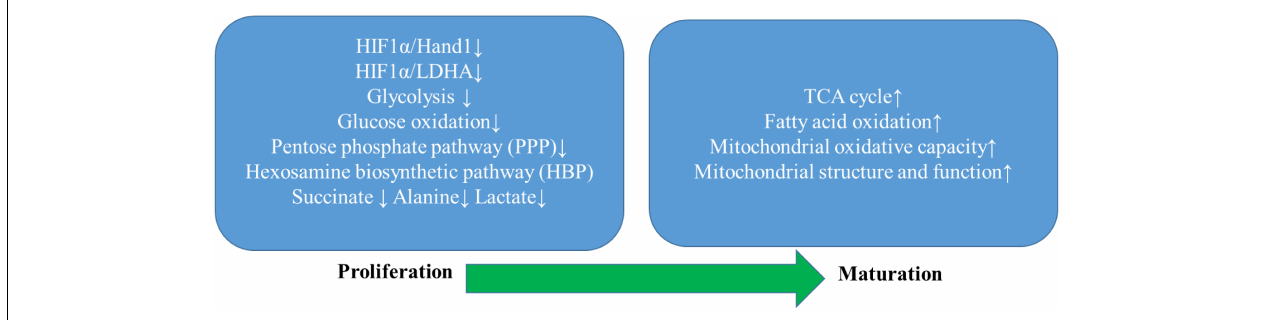
FIGURE 2 | Summarization of progress of metabolic remodeling in the developing heart. The developing heart undergoes a unique metabolic switch from the primary utilization of glucose through the glycolytic pathway and auxiliary biosynthetic pathways, including the pentose phosphate pathway (PPP) and the hexosamine biosynthesis pathway (HBP) to fatty acid oxidation as the mitochondrial structure and function mature to substantially improve mitochondrial oxidative capacity. Intermediate metabolites that are specifically increased during proliferation, such as lactate, alanine, succinate, and triglycerides, are markedly decreased during maturation. At the transcriptional level, maturation of cardiomyocytes relies on a sharp decrease in the expression of the hypoxia-inducible factor 1 subunit a (HIF1a), HIF1a-dependent cardiac transcription factor heart, and neural crest-derived transcript-1 (Hand1), and lactate dehydrogenase A (LDHA). Thus, inhibition of the HIF1 α /Hand1 and HIF1 α /LDHA signaling plays a crucial role in the time-dependent metabolic shift toward increased metabolic flux to the TCA cycle as the predominant metabolic pathway of oxidative